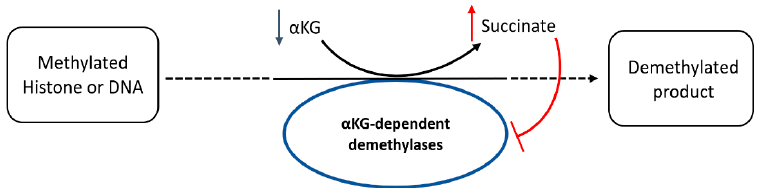
Figure 16. α KG-dependent DNA or protein demethylases use α KG as a substrate and generate succinate as a product, which in high levels can inhibit their activity (oversimplified scheme).